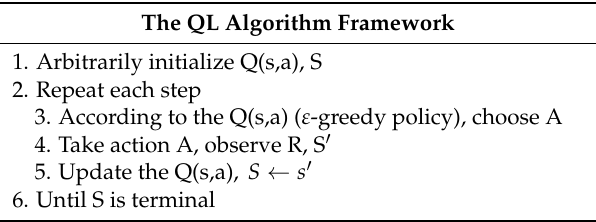
Table 2. The pseudocode of Q–Learning (QL)